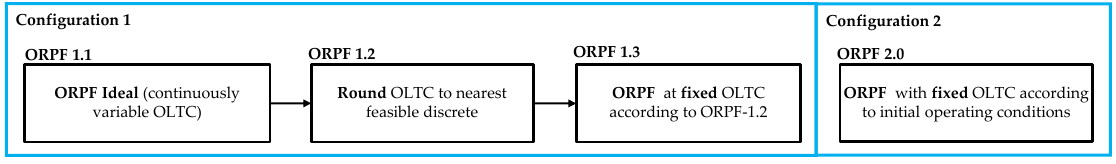
Figure 17. Tested Optimal Reactive Power Flow (ORPF) configurations.